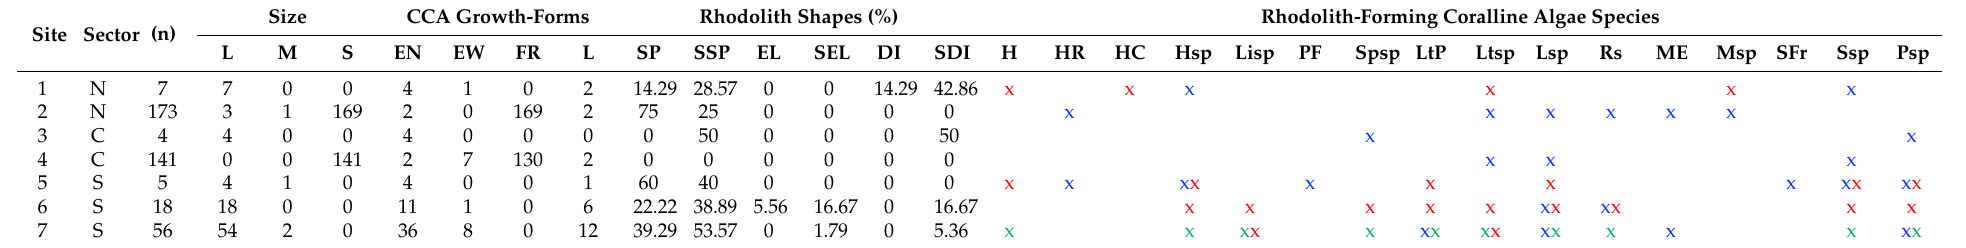
Table 2. Rhodolith size, coralline algal growth-form, rhodolith shape (%) and rhodolith-forming coralline algal species from the SEAL Basin. Surface (x-blue); outermost portion (x-green); innermost portion (x-red).